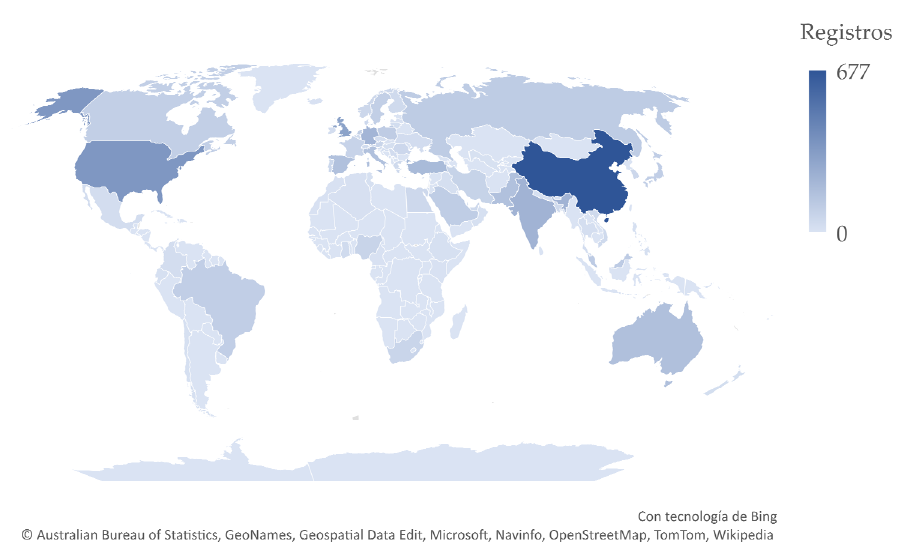
Figure 5. Number of records by countries. Source: Own elaboration based on WoS.